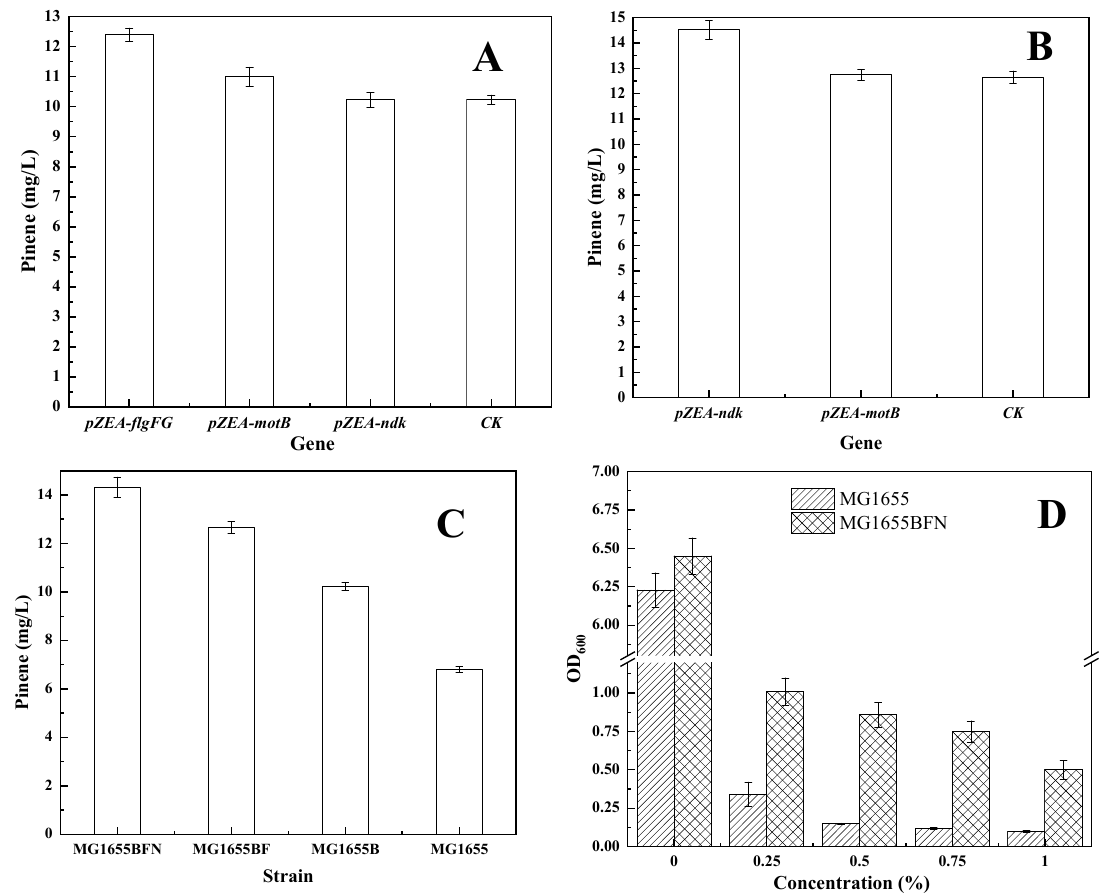
Figure 5. Effect of targeted strains on pinene production and growth. ( A ) Expression of plasmid in E. coli MG1655B (pMEVIGPS). E. coli MG1655B (pZEABP and pMEVIGPS) was set as the control (CK). ( B ) Expression of plasmid in E. coli MG1655BF (pMEVIGPS). E. coli MG1655BF (pMEVIGPS and pZEABP) was set as the control (CK). ( C ) Pinene production by the targeted strains harboring pMEVIGPS. ( D ) Growth of the selected strains (without plasmids) with different pinene addition after 12 h.